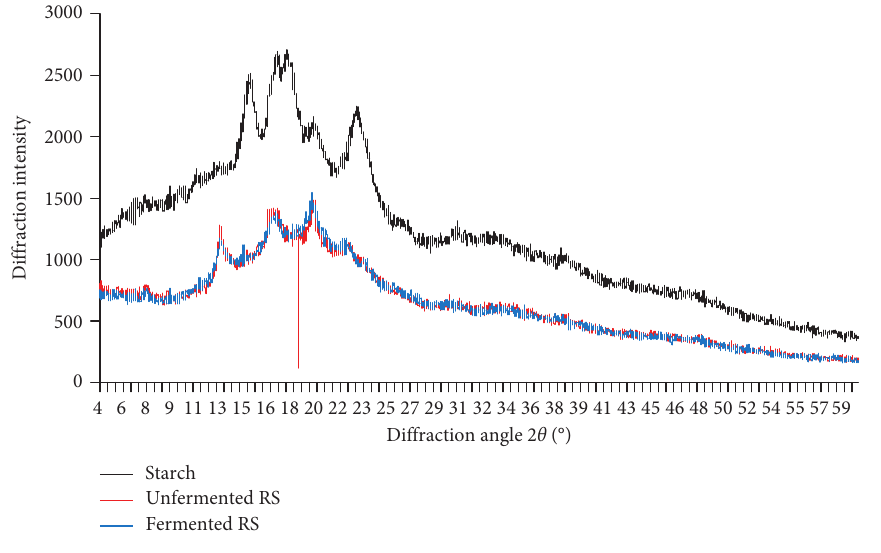
Figure 3: X-ray diffraction patterns of sorghum starch and resistant starch. Table 5: X-diffraction 2 θ angle and peak width of sorghum starch and resistant starch. Peak serial